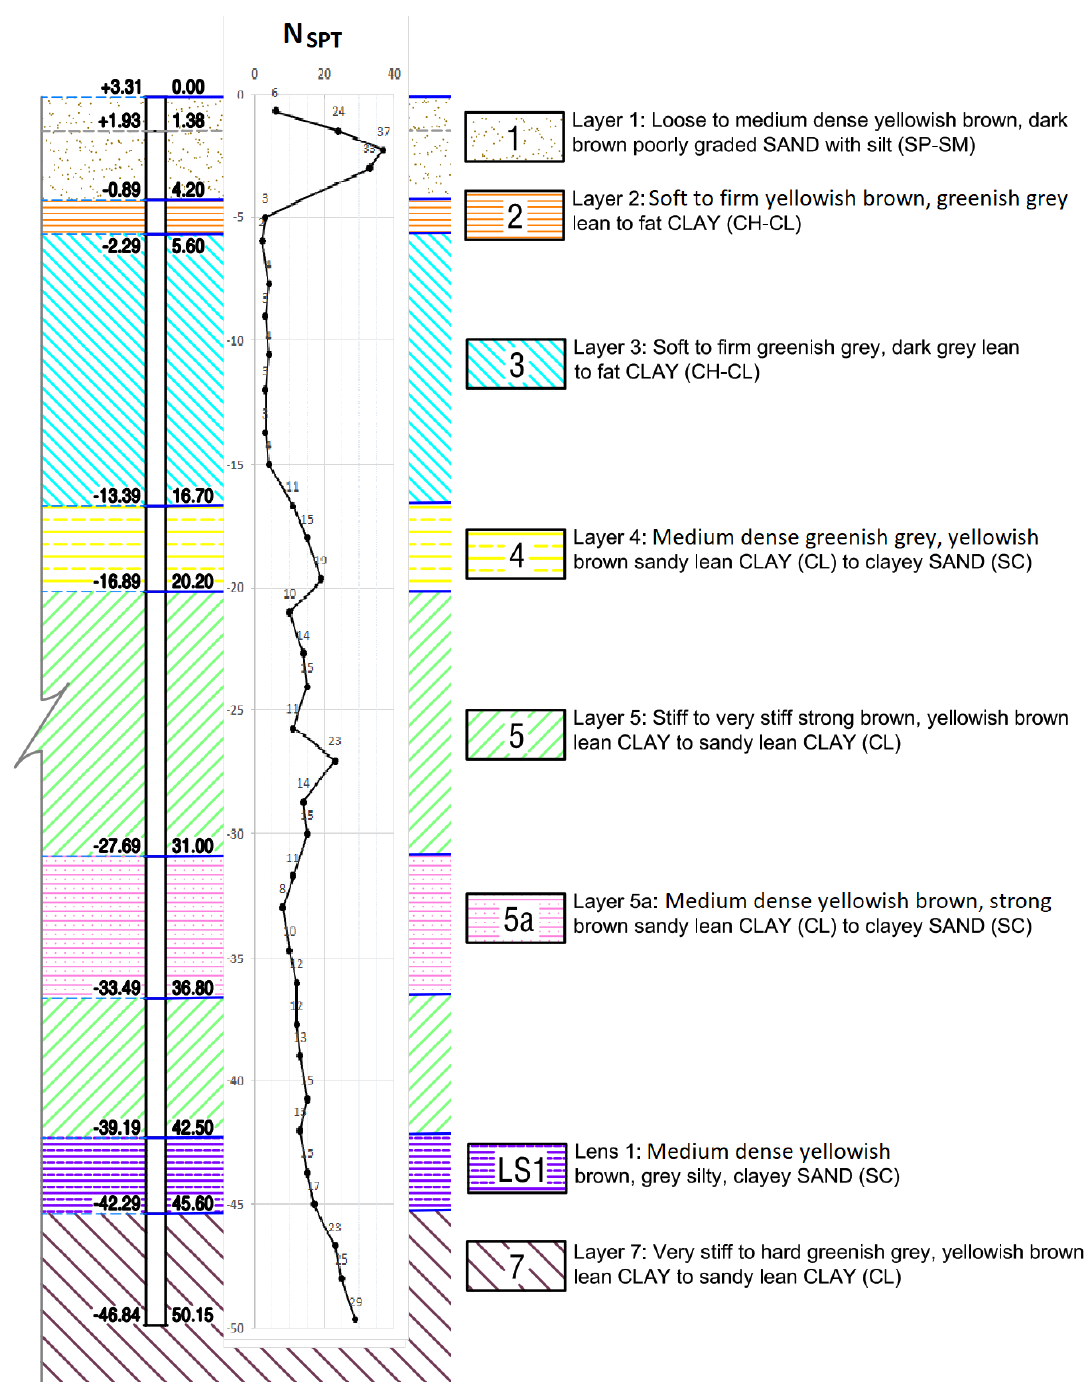
Figure 2. Boring Log BH6 (typical for the study area).